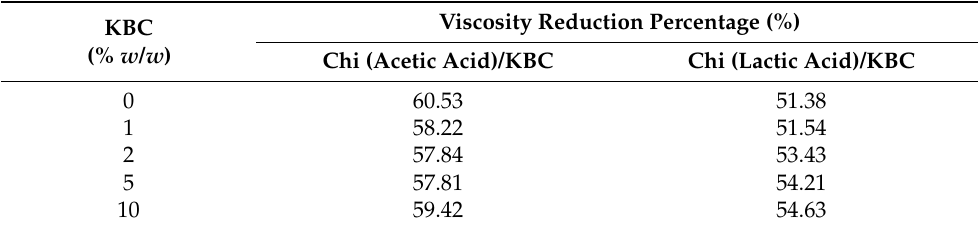
Table 2. The viscosity reduction percentage of Chi/KBC film-forming solutions as temperature increases from 25 ◦ C to 40 ◦ C.